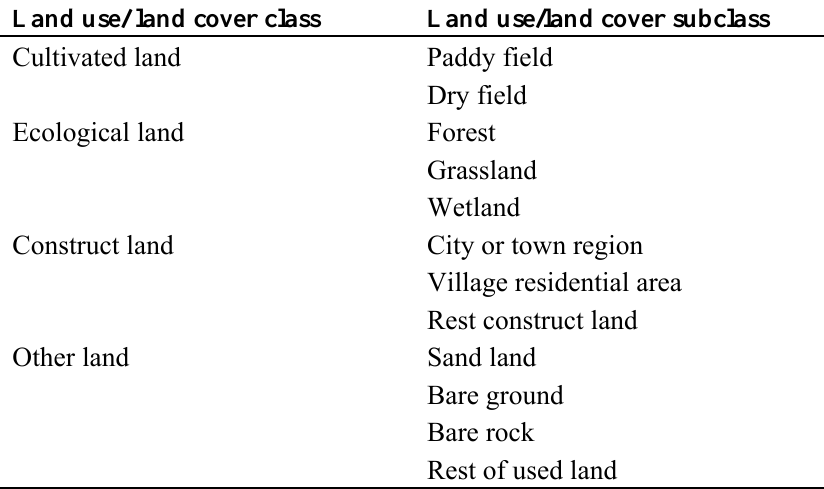
Table 1. Land use and land cover of the study